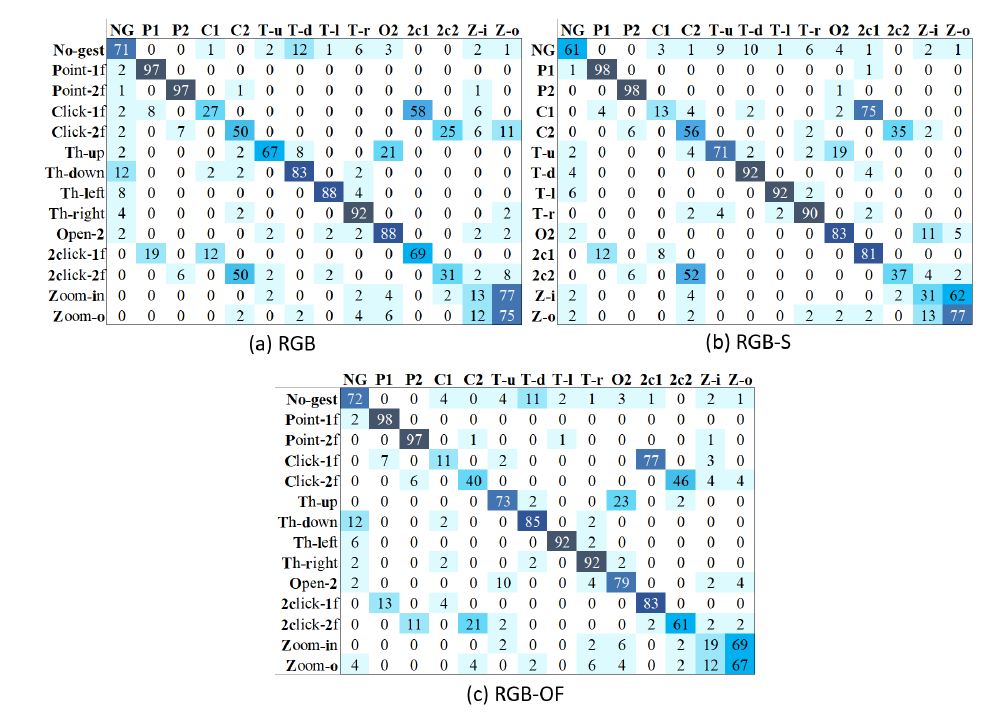
Figure 10. Confusion matrices of TSN with different input modalities.